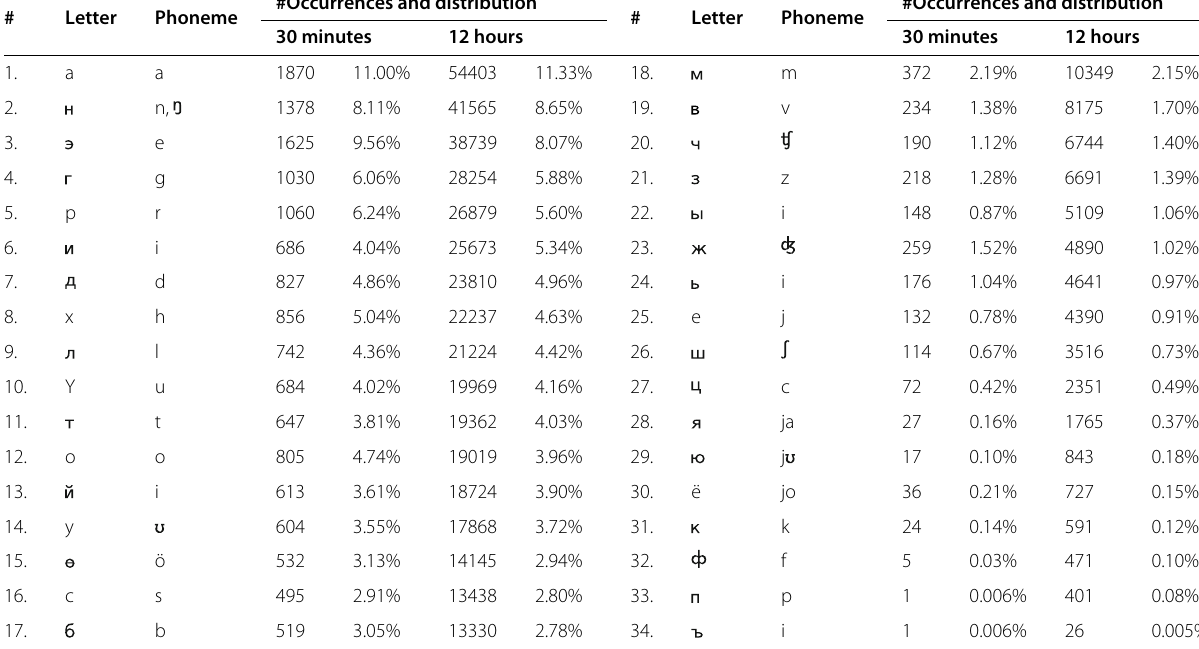
Table 3 Occurrences and distributions of Mongolian letters in the 30-min and 12-h target language datasets and IPA phonetic